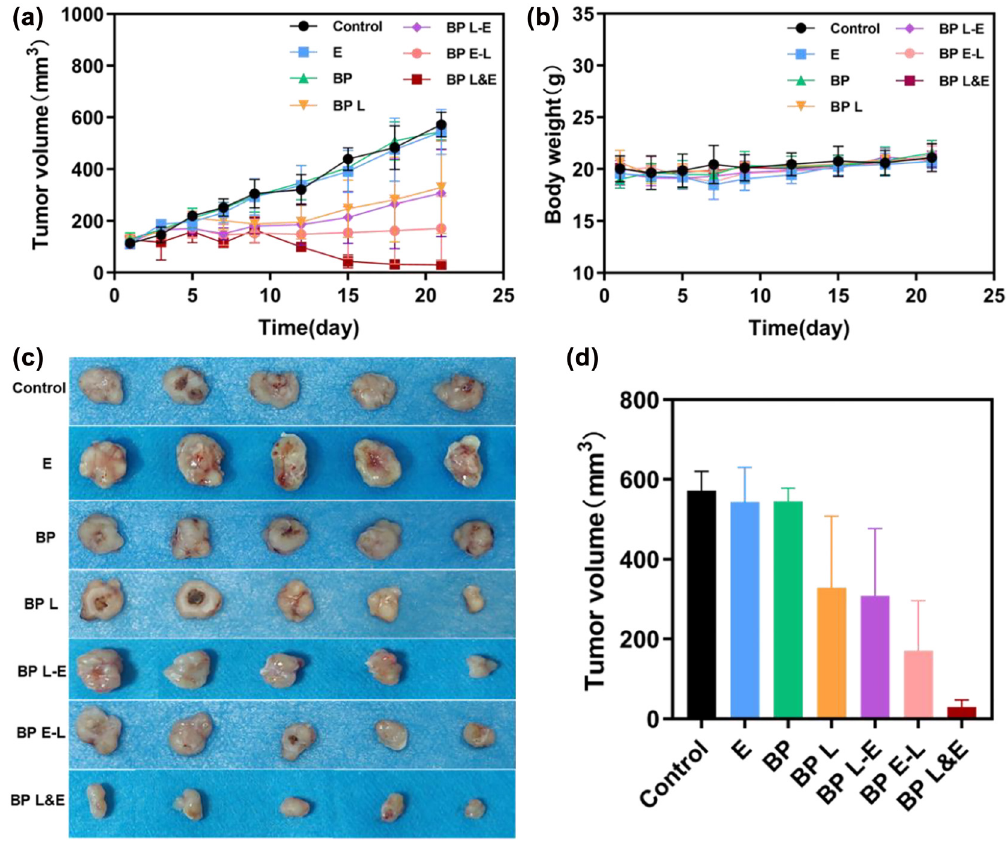
Figure 6: In vitro evaluations of BP-based nanomaterials post various treatments. (a) Tumor volume development over time after different treatments, n = 5, (b) body weight changes over time of different groups, n = 5, (c) images of harvested tumor tissue after 21 days, (d) statistical analysis of tumor volume on 21